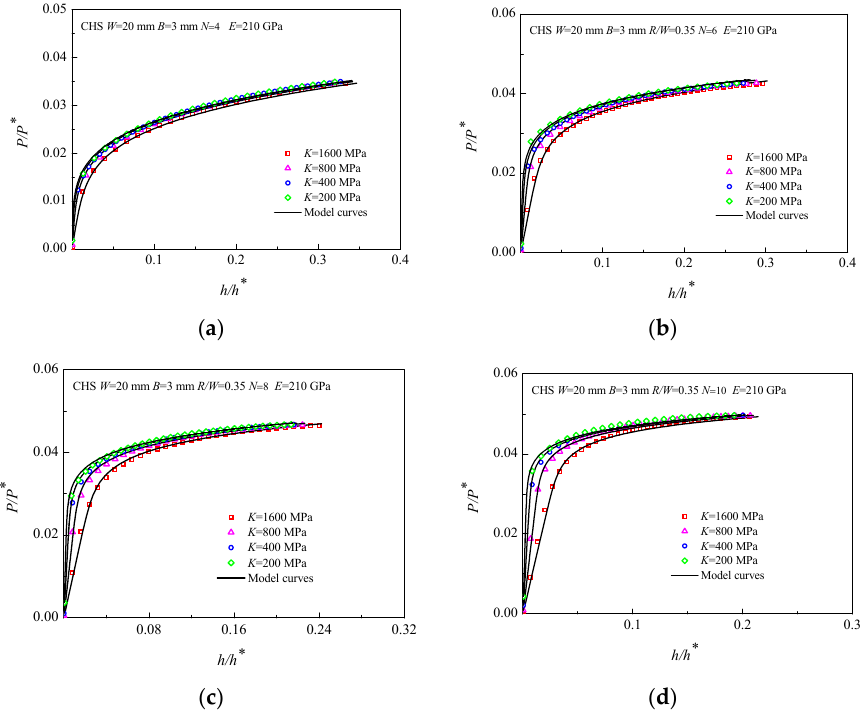
Figure 7. P/P* ~ h/h * curves of the CHS specimens with strength coefficient K, ( a ) E = 210 GPa N = 4; ( b ) E = 210 GPa N = 6; ( c ) E = 210 GPa N = 8; ( d ) E = 210 GPa N = 10 . Figure 8 shows the P/P *~ h/h * curves of the materials with different elastic moduli E , where K was set to 200,400, 800, and 1600 MPa, N was set to 6 and 8, and E was set to 70, 110, and 210 GPa. Taking the CHS specimens with R/W = 0.35 as an example, it is illus- trated that the P/P *~ h/h * curves of the materials with the same K and N but variable E are different; however, they are very close to each other. The influence of E on the CHS-LD model is also concentrated on the elastic stage of the P/P *~ h/h * curves.